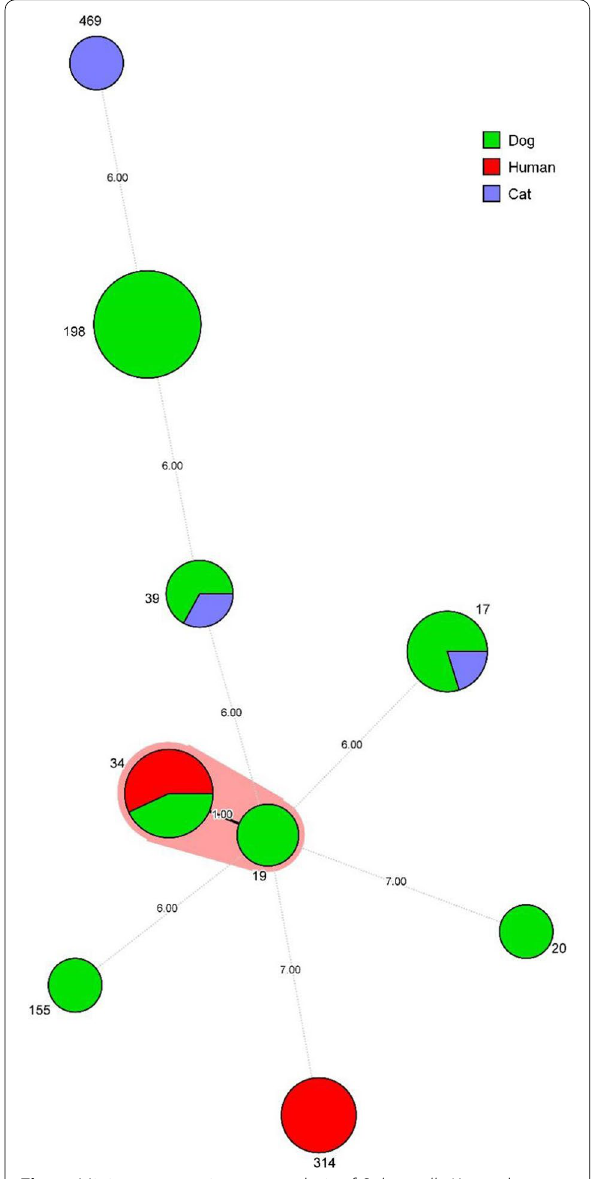
Fig. 1 Minimum spanning tree analysis of Salmonella Kentucky isolated from cats, dogs and humans. Each circle represents one ST, and the area of the circle corresponds to the number of isolates. Different sources are represented by green, red and light blue respectively